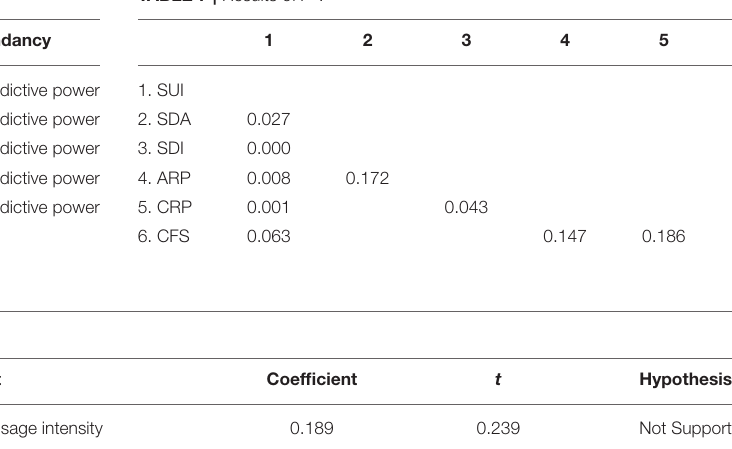
TABLE 5 | Results of redundancy analysis. TABLE 7 | Results of F 2 .